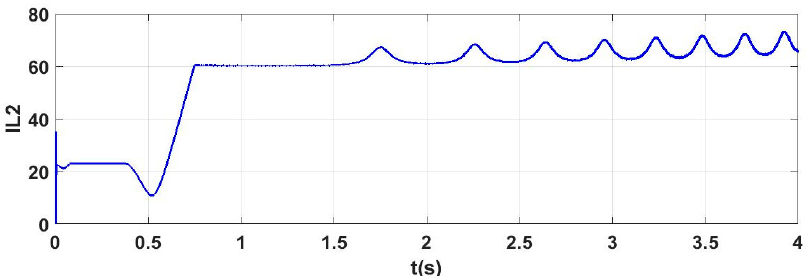
Figure 14. Output current I l 2 f or τ = 0.5